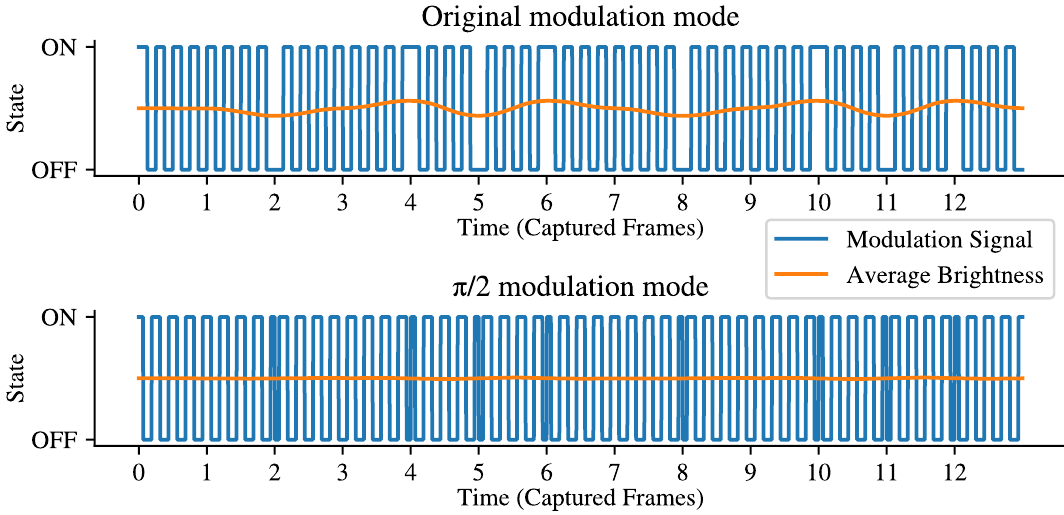
Figure 14. Average brightness of modulated light sources.